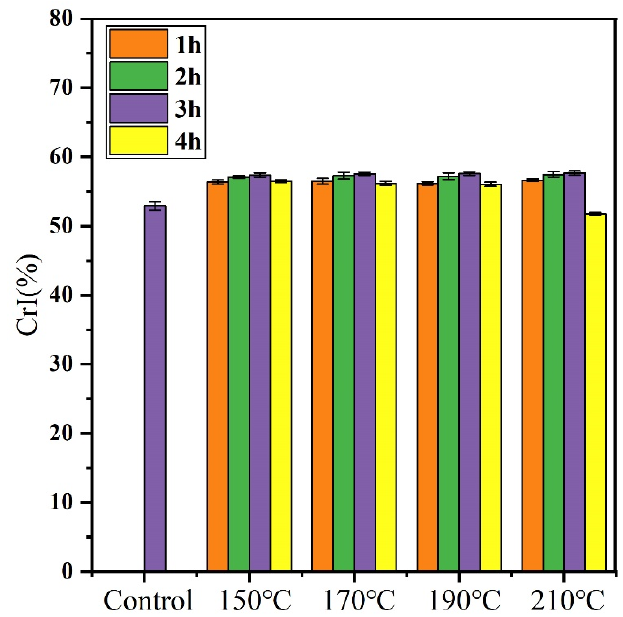
Forests 2022 , 13 , x FOR PEER REVIEW Figure 8. CrI of different bamboo samples after nitrogen heat treatment. Figure 8. CrI of different bamboo samples after nitrogen heat treatment.